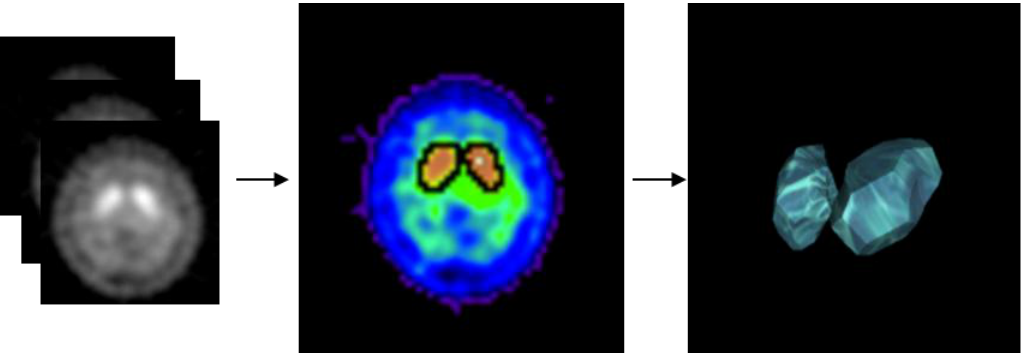
Figure 4. Using Seed region growing method calculate the volume of striatal activity. ( left ) 99m Tc-TRODAT-1 SPECT image, ( middle ) striatal activity in single slide, ( right ) whole brain (3D) striatal activity.